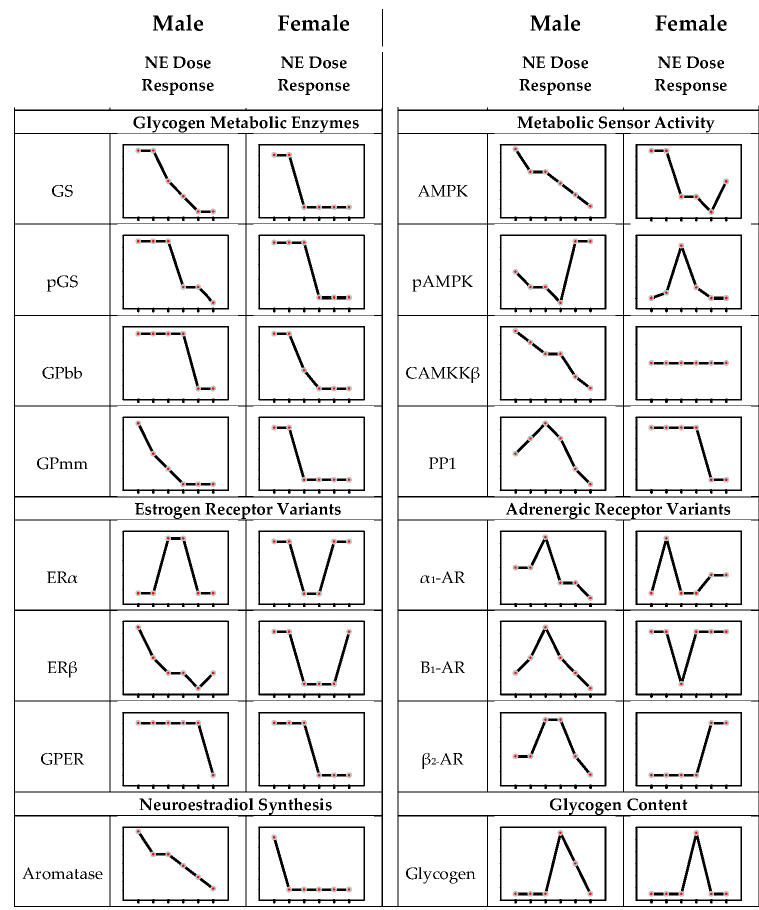
Figure 2. Norepinephrine (NE) regulation of the hypothalamic astrocyte glycogen metabolic enzyme and adrenergic and estrogen receptor variant protein expression and glycogen content in male versus female primary hypothalamic astrocyte cell cultures. In each graph, tick marks along the x axis indicate, from right to left, astrocyte incubation with NE over a dosage range of 0, 0.1, 1.0, 10.0, 100.0 or 1000 nM. Abbreviations: α 1 ‐ AR: alpha 1 ‐ adrenergic receptor; α 2 ‐ AR: alpha 2 ‐ adren ‐ ergic receptor; β 1 ‐ AR: beta 1 ‐ adrenergic receptor; β 2 ‐ AR: beta 2 ‐ adrenergic receptor; AMPK: 5 ′‐ AMP ‐ activated protein ki ‐ nase; CaMMKB: calcium/calmodulin ‐ dependent protein kinase kinase ‐β ; ER α : estrogen receptor ‐ alpha; ER β : estrogen re ‐ ceptor ‐ beta; GS: glycogen synthase; GPbb: glycogen phosphorylase brain type; GPER: G ‐ protein ‐ coupled estrogen recep ‐ tor ‐ 1; GPmm: glycogen phosphorylase muscle type; pAMPK: phosphoAMPK; pGS: phosphoGS; PP1: protein phospha ‐ tase ‐ 1. Sex differences in the noradrenergic regulation of glia AR and ER expression in ‐ volved dosage efficacy and direction of regulatory action. In male rats, β 1 ‐ and β 2 ‐ AR pro ‐ tein profiles exhibited bi ‐ directional responses to increasing NE doses; female astrocytes